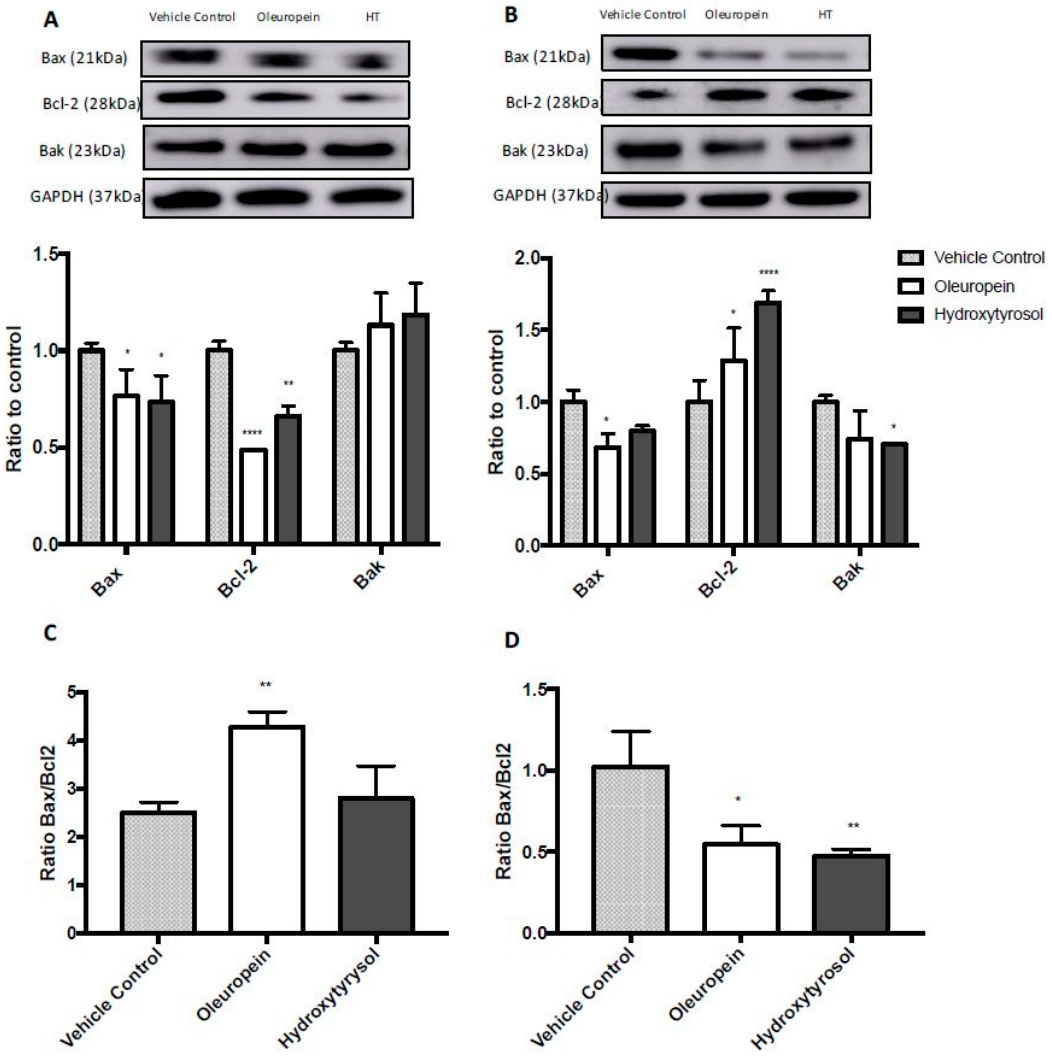
Figure 5. Expression of Bax, Bak and Bcl-2 in MIA PaCa-2 ( A ) and HPDE ( B ) cells treated with oleuropein (200 µM) and hydroxytyrosol (HT) (100 µM) or vehicle control as assessed using gel electrophoresis and Western blotting. GAPDH was used as a loading control. Results displayed as optical density measurements of target antibody/GAPDH/control average; hence, results are represented as fold change. Ratio of the expression of Bax to Bcl-2 in MIA PaCa-2 ( C ) and HPDE ( D ) cells. For ( A , B ), ordinary two-way ANOVA with Tukey’s multiple comparisons test compares protein expression of treated cells (oleuropein or hydroxytyrosol) to vehicle control; for ( C , D ), ordinary one-way ANOVA with Tukey’s multiple comparisons test compares Bax/Bcl-2 ratio of treated cells to vehicle control. * p 0.05, ** p 0.01, *** p 0.001, **** p < 0.0001.